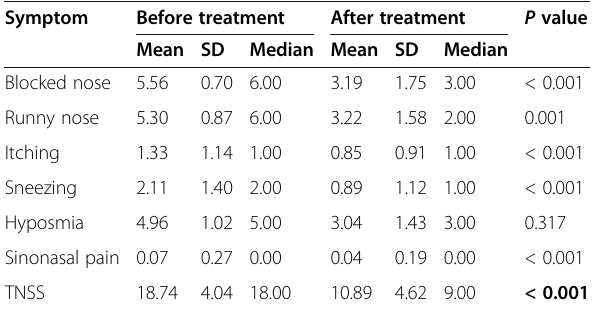
Table 3 Total nasal symptoms score (TNSS) before and after treatment in the injection group